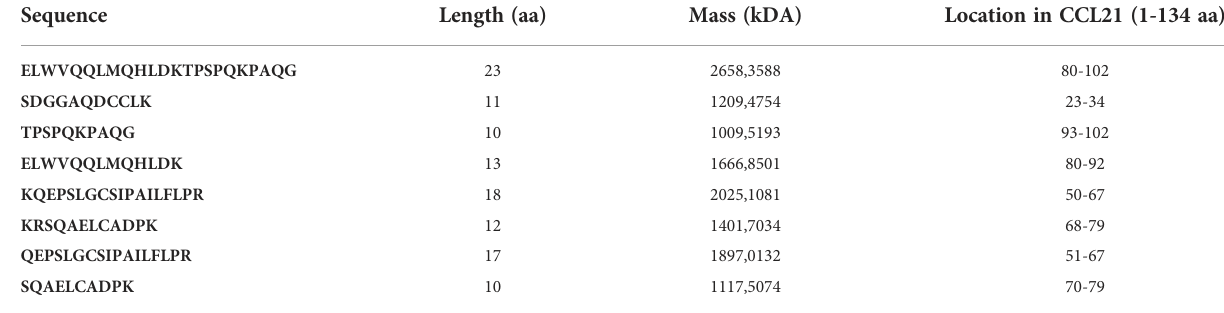
aa, amino acids; kDA, kilo